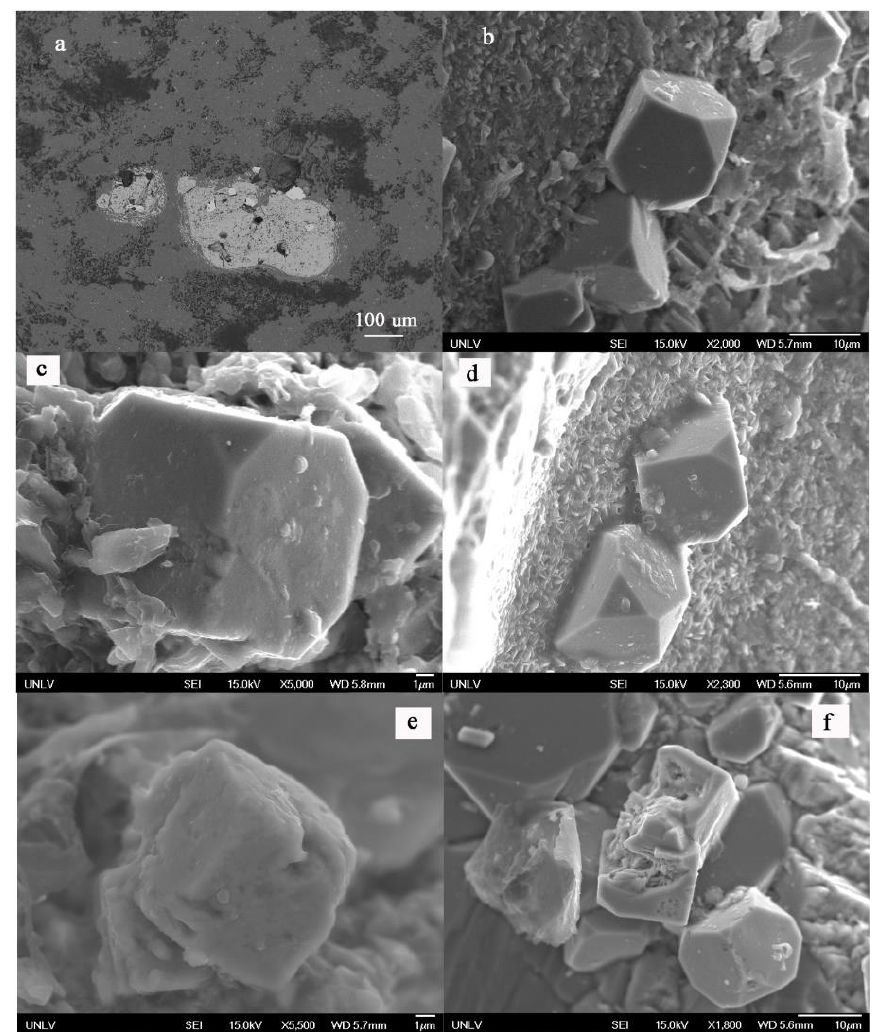
Figure 8. Images of greenalite and arsenogoyazite. ( a ) Subrounded grains of Si-Fe mineral (greenalite) coexists with magnetite (bright grains in the greenalite) in the matrix. ( b – d ) Arsenogoyazite crystals show their possible 3-fold axes, indicating a trigonal symmetry. ( e , f ) The dissolving pits on the arsenogoyazite crystals indicate their potential dissolving capability when touching meteoric water.